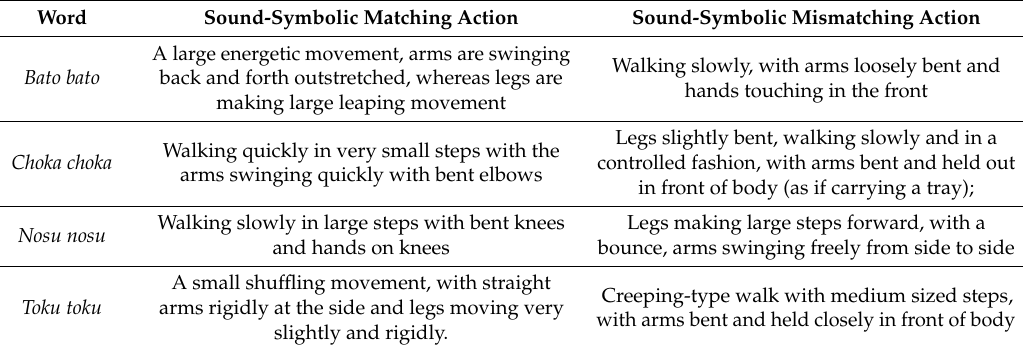
Table 1. Description of the matching and mismatching actions for each sound-symbolic